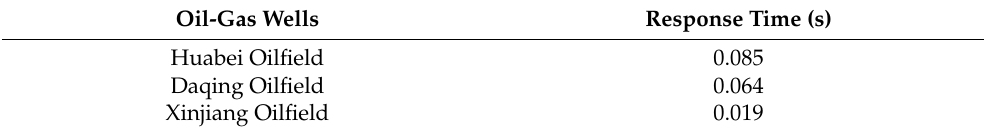
Table 7. Fast response time for three major oil fields.